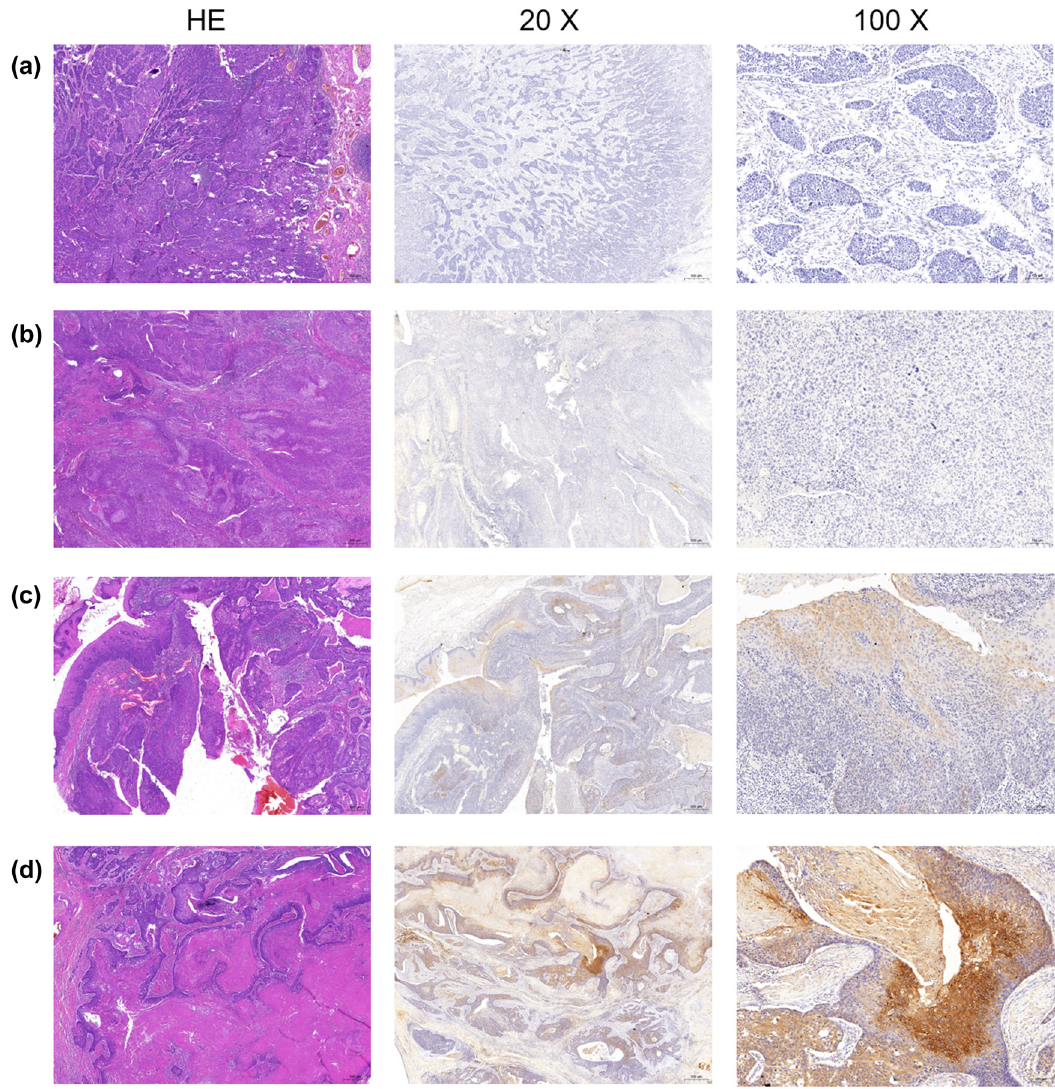
Figure S1: The expression of α 2 δ 1 was variable among HSCC samples. The histological images of 4 representative cases ( a – d ) were presented. For each case, the HE staining section and immunohistochemistry staining of α 2 δ 1 with di ff erent magni fi cations ( 20 × and 100 ×) were shown. The expression of α 2 δ 1 varied greatly among these 4 HSCC